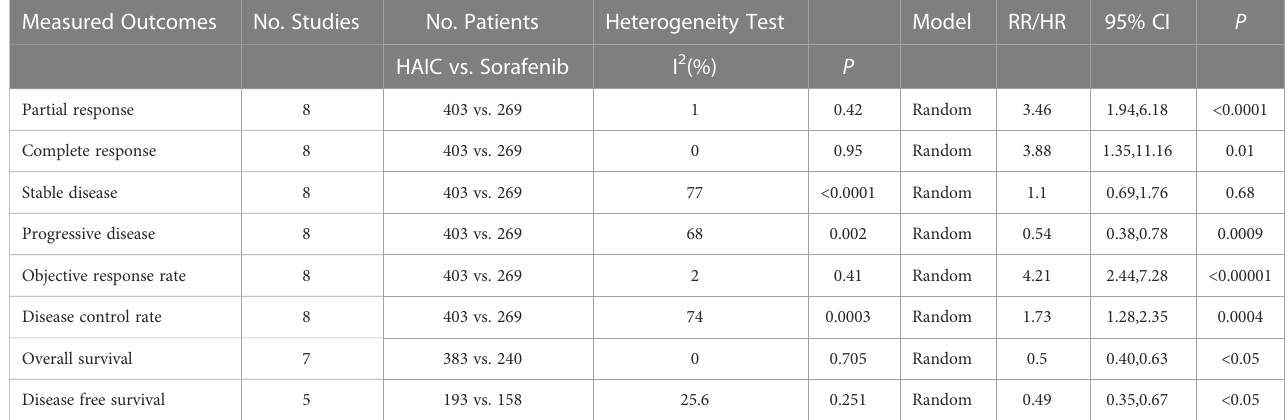
TABLE 3 Meta-analysis results of all available studies in measured outcomes.